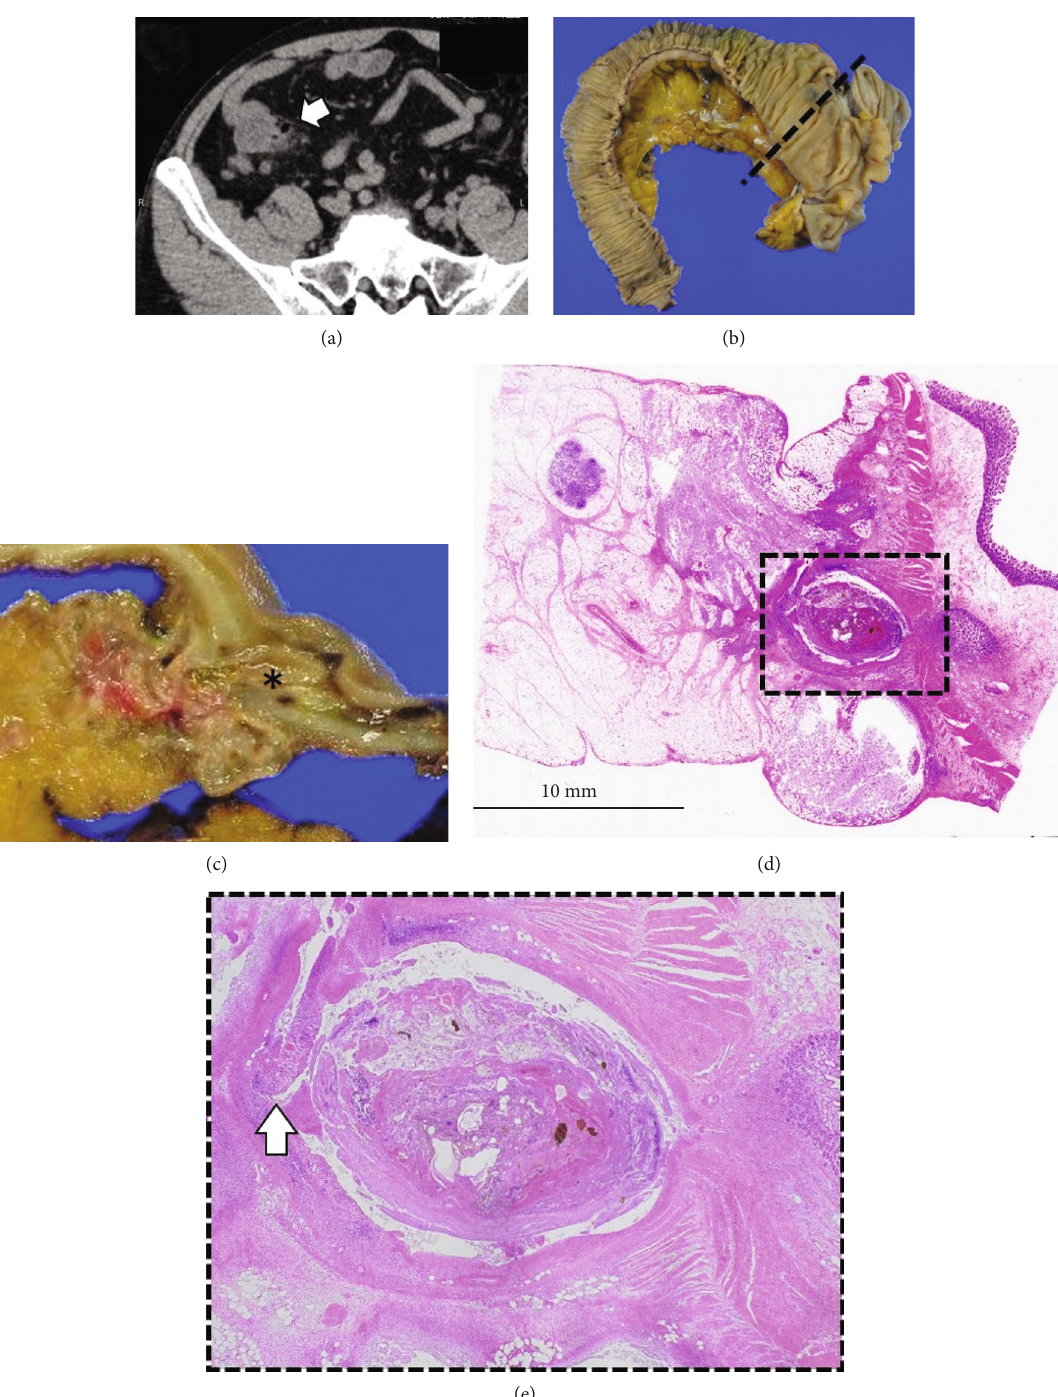
Figure 2: Case 2 fi ndings. (a) CT scan showed penetration of terminal ileum diverticulitis and air (white arrow) in the near mesentery. (b) Resected specimen after ileocecal resection showed the presence of diverticulum. The dotted line represents the cross section line for Figure 2(c). (c) Specimen cross section of penetration from diverticulitis (asterisk). (d) Microscopic feature (H&E). In fl ammation due to diverticulitis is observed in the area enclosed by the dotted square. (e) Microscopic examination (H&E) of the tissue within the dotted square from Figure 2(d). An area of in fl ammation was observed in the intestinal mucosa (arrow) with